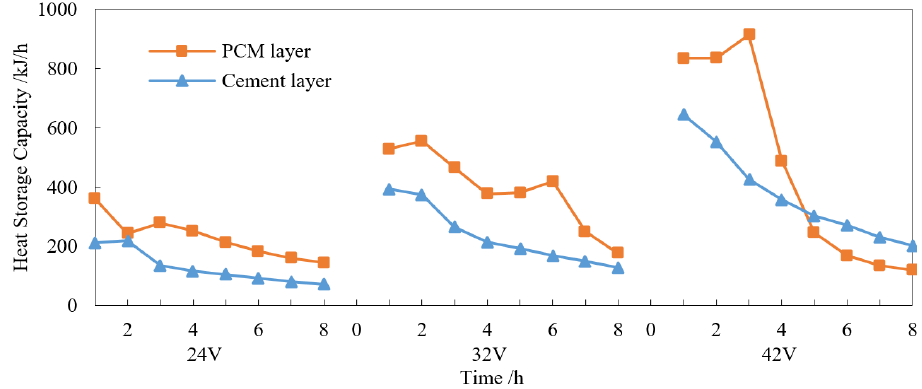
Figure 15. Comparative experimental results of heat storage capacity of layer V between the two wallboards.